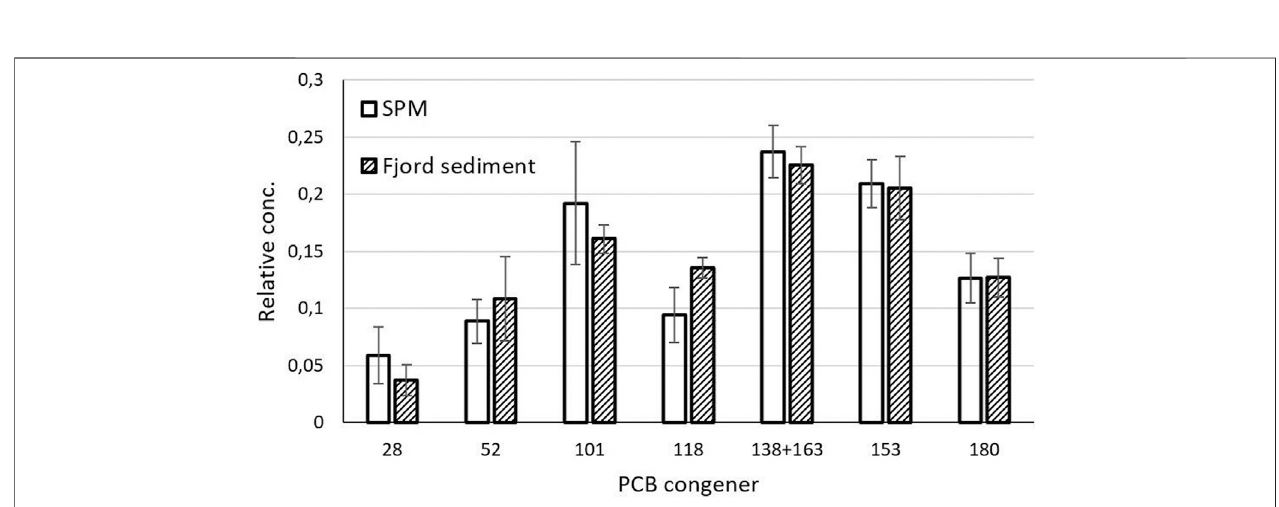
FIGURE 6 | PCB pro fi les, expressed as the fraction of each compound as part of the total PCB 7 concentration, in the SPM samples (n (cid:1) 6) compared to sediment samples in the Oslo fjord near the river mouth (n (cid:1) 5) from Arp and Breedveld (2009).